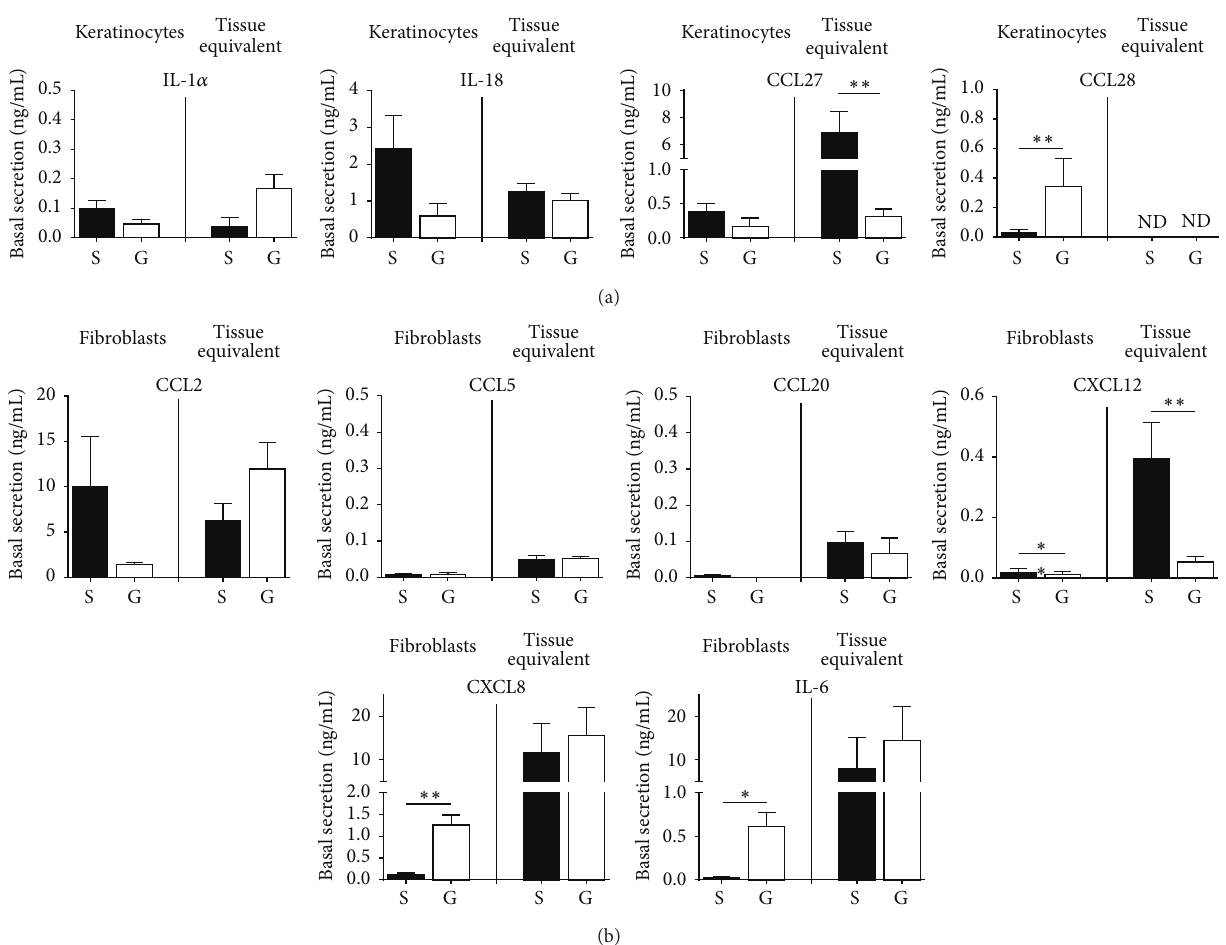
Figure 2: Basal cytokine and chemokine secretion by keratinocytes, fibroblasts, and tissue equivalents. (a) Cytokine/chemokine secretion by skin (S) and gingiva (G) keratinocytes and tissue equivalents. (b) Cytokine/chemokine secretion by skin and gingiva fibroblasts and tissue equivalents. Culture supernatants were collected over 24 h and analysed by ELISA. Data represent the average of at least 8 individual experiments ± SEM; ∗ 𝑝 < 0.05 ; ∗∗ 𝑝 < 0.01 (unpaired Student’s 𝑡 -test). ND = not